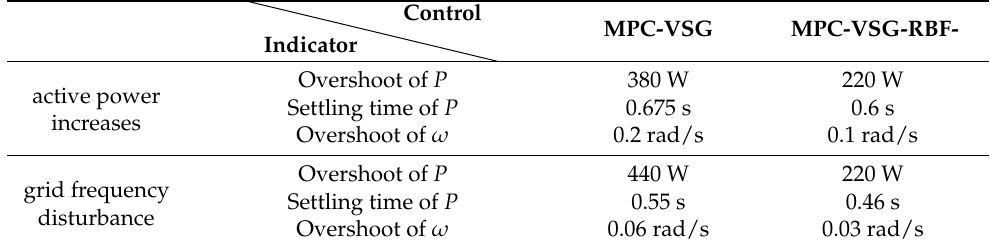
Table 3. Indicator values of active power increases and grid frequency disturbance.